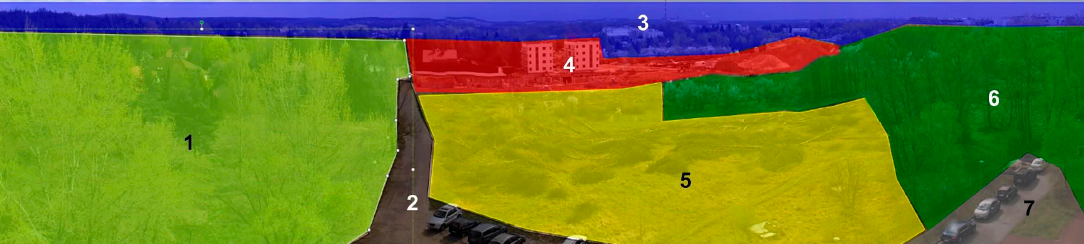
Figure 2. Areas of interest designated for the analysis: ( 1 ) northern forest, ( 2 ) road, ( 3 ) horizon, ( 4 ) construction area, ( 5 ) tree-felling area, ( 6 ) southern forest, ( 7 ) car park.